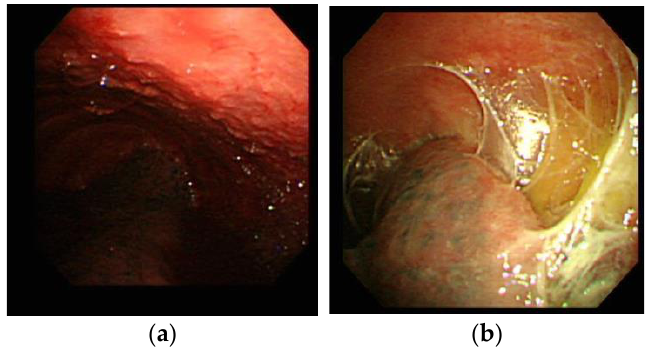
Figure 2. ( a ) A representative case of tuberculous pleurisy. The pleuroscopic image shows micronodules; ( b ) A representative case of an adhesion lesion. The pleuroscopic image shows the presence of fibrous bands between the visceral and parietal pleura. Table 3. TB cultures of the TB pleurisy patients by pleuroscopic